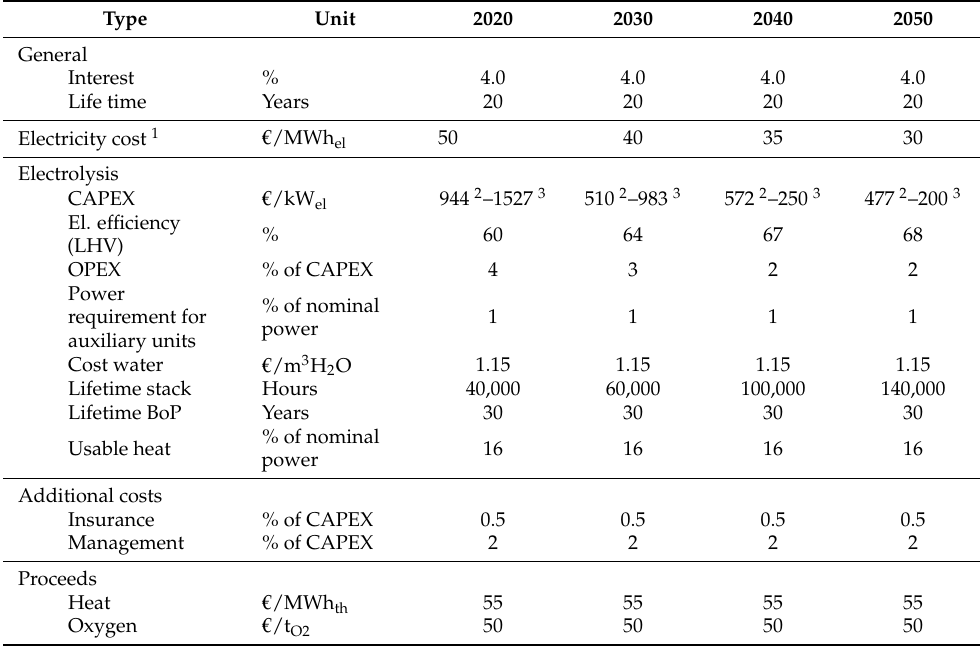
Table 2. Cost structures of the electrolysis reference